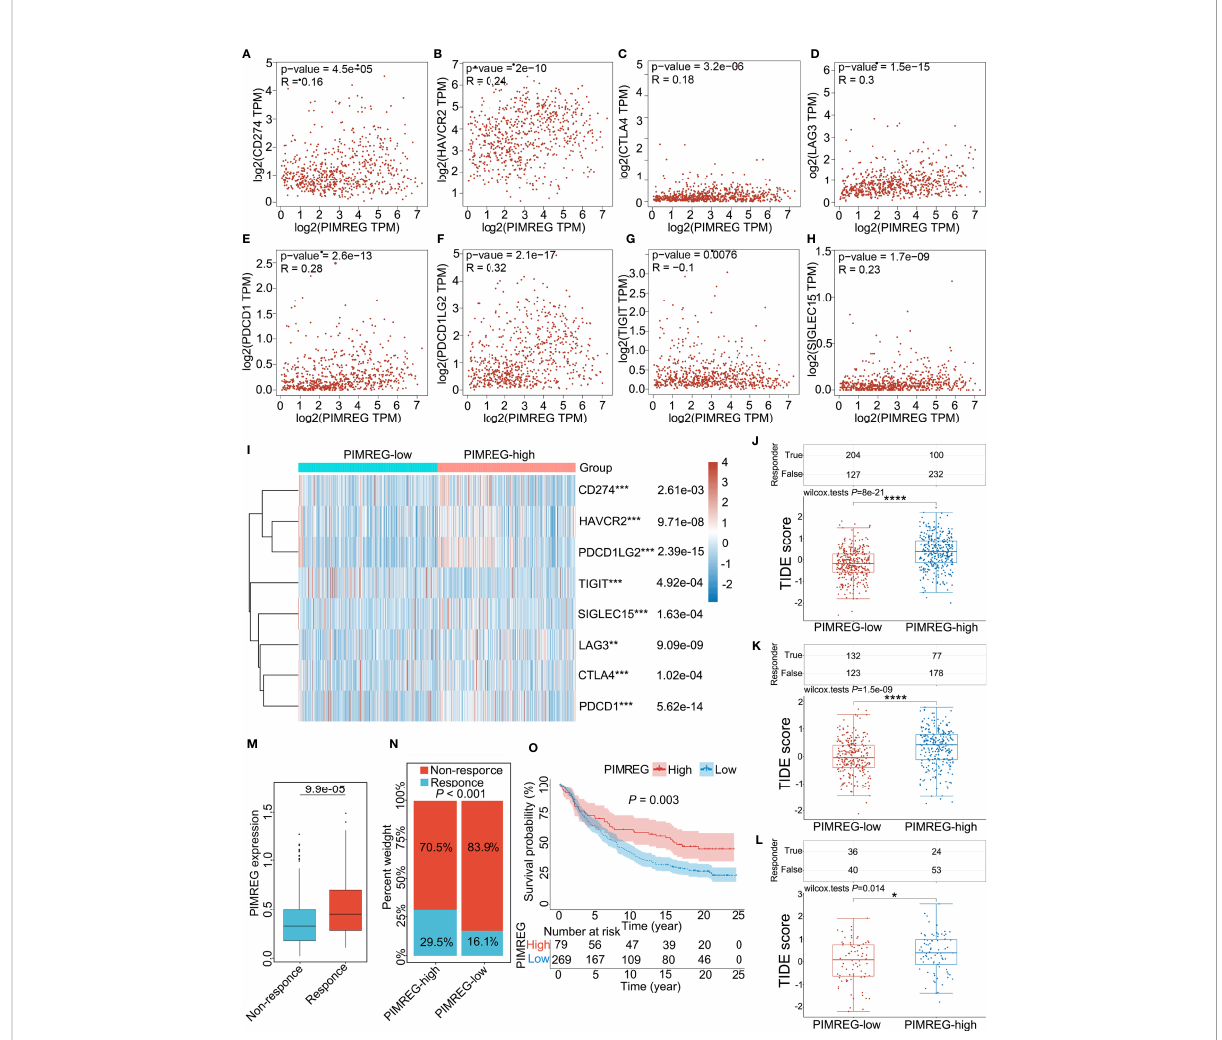
FIGURE 7 Correlation between PMREG and immune checkpoints and response to immunotherapy. Correlation of PIMREG with the immune checkpoints CD274 (A) , HAVCR2 (B) , CTLA4 (C) , LAG3 (D) , PDCD1 (E) , PDCD1LG2 (F) , TIGIT (G) , and SIGLEC15 (H) in gliomas (LGG+GBM). (I) Heatmap of immune checkpoint expression in gliomas with high and low PIMREG expression (LGG+GBM). (J) Different TIDE scores in gliomas (LGG + GBM) with high and low expression of PIMREG. (K) Different TIDE scores in LGG with high and low expression of PIMREG. (L) Different TIDE scores in GBM with high and low expression of PIMREG. (M) PIMREG expression in the response and nonresponse groups to anti-PD-1 therapy in the IMvigor210 cohort (anti-PD-L1, urological). (N) The ratio of patients who responded to anti-PD-1 therapy in the low- and high-PIMREG groups of the IMvigor210 cohort. (O) Kaplan – Meier curves for the low- and high-PIMREG patient groups in the IMvigor210 cohort. * P < 0.05; ** P < 0.01; *** P < 0.001; **** P <